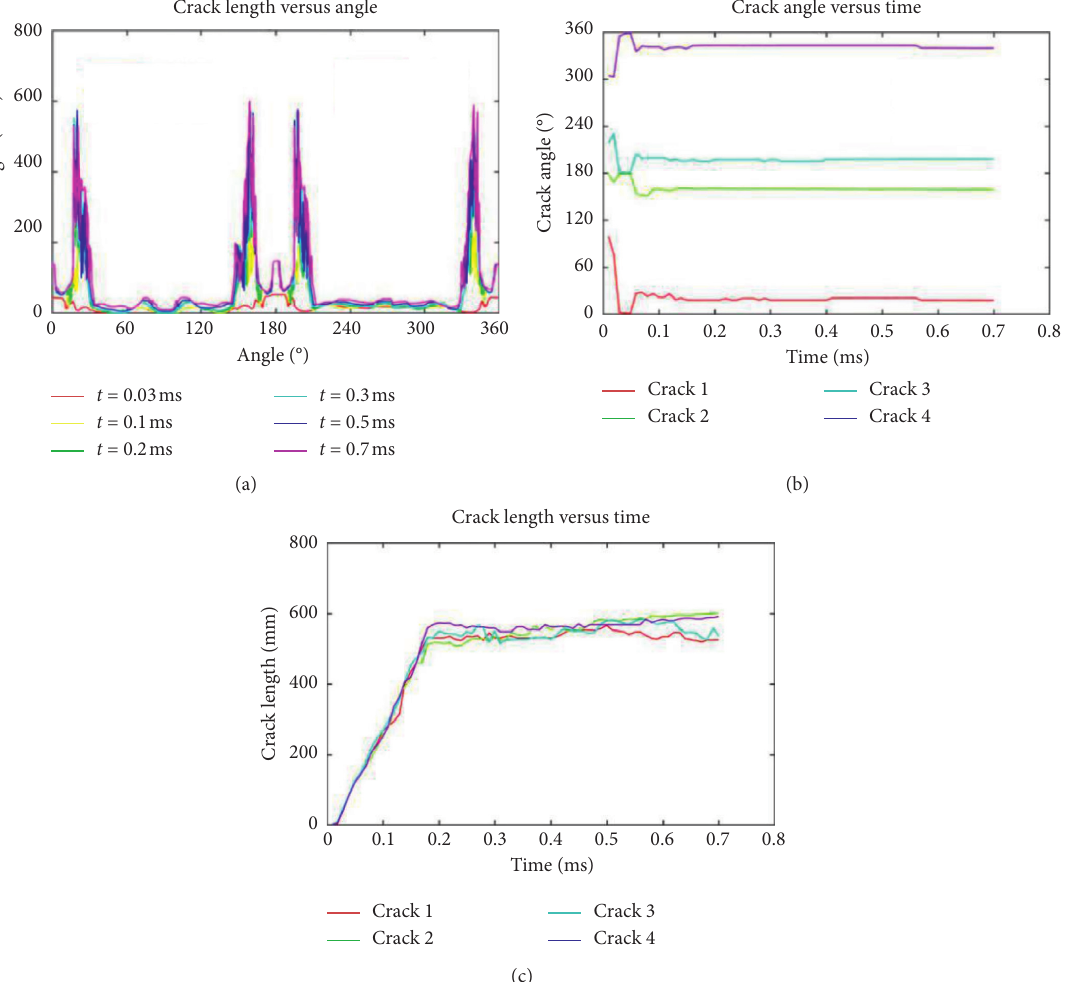
Figure 13: Schematic diagram of 45 ° shaped energy blasting crack. (a) Crack angle versus crack length for 45 ° shaped energy angle. (b) Time evaluation of crack angle for 45 ° shaped energy angle. (c) Time evaluation of crack length for 45 ° shaped energy